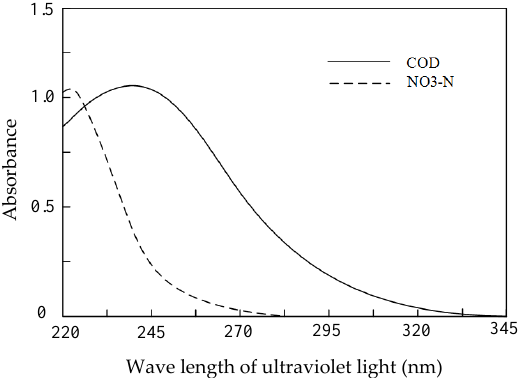
Figure 3. The ultraviolet absorbance of COD and nitrate nitrogen (NO 3 –N).